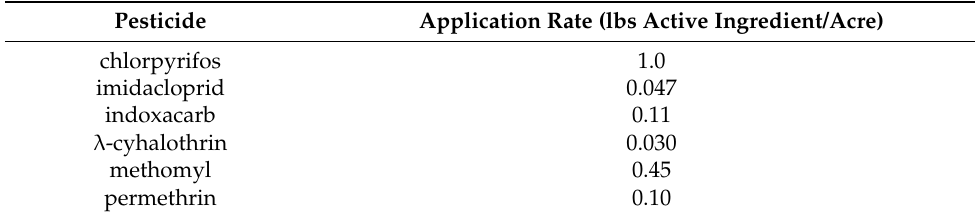
Table 3. Pesticide application rates simulated in